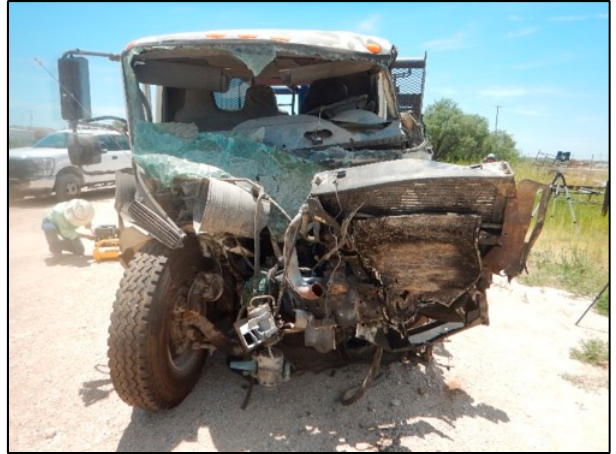
Figure 5. International truck, post-collision, front view.